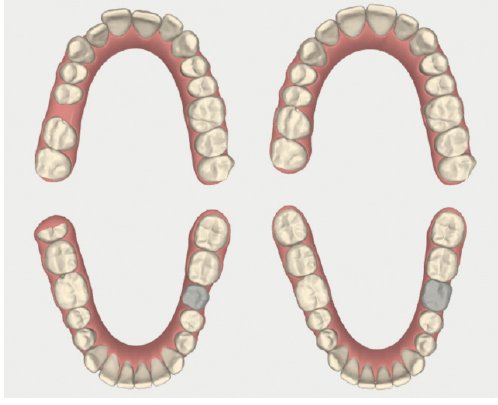
Figure 15. Case 2: initial and final digital occlusal images.